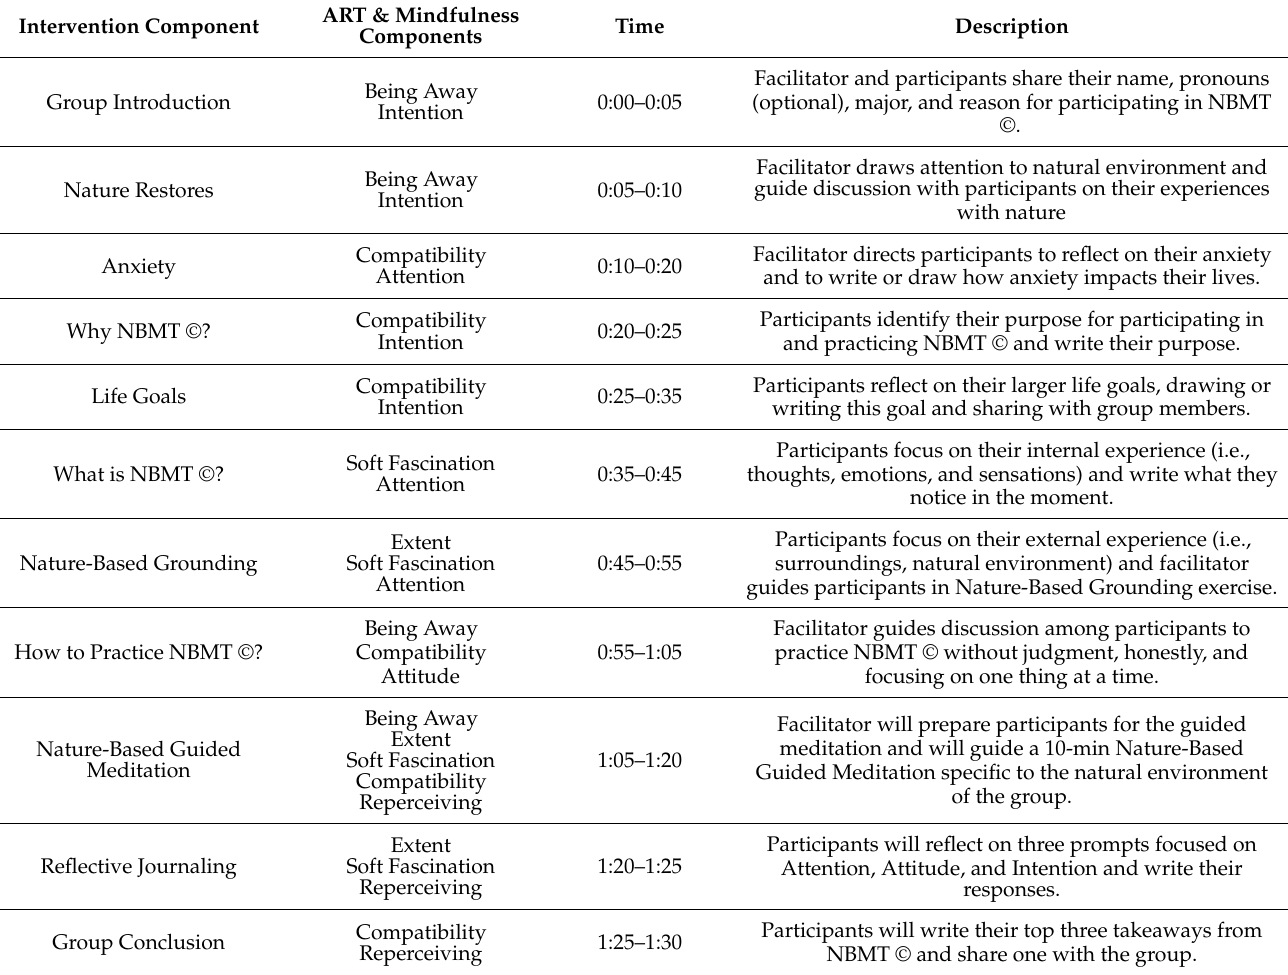
Table 2. NBMT © Intervention Components: Time and